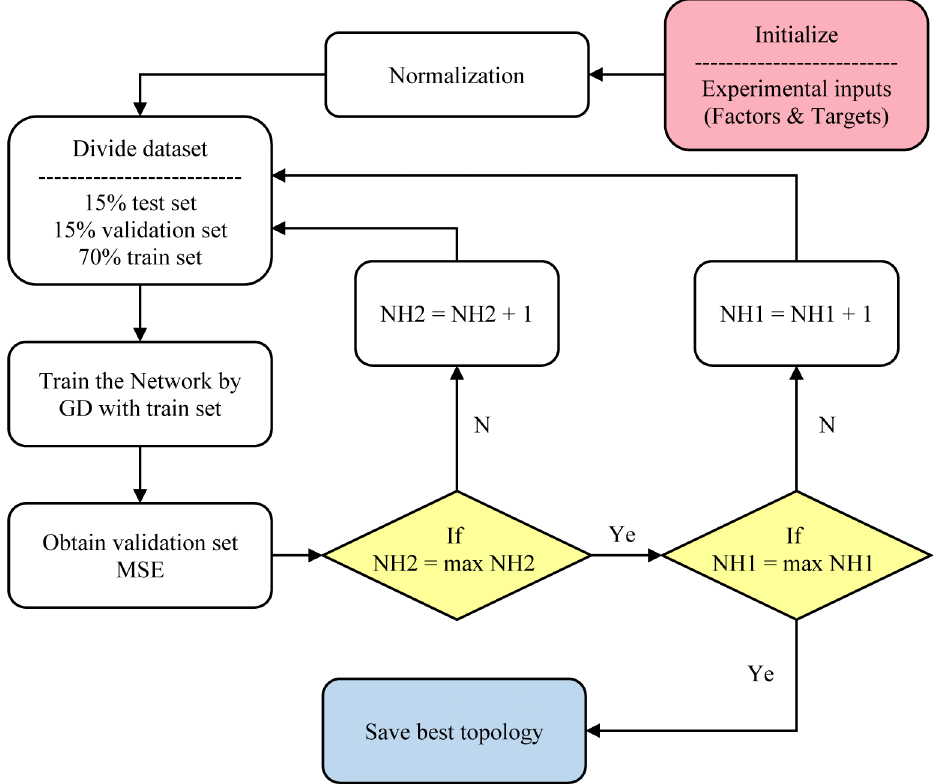
Figure 1: Modeling flowchart based on ANN